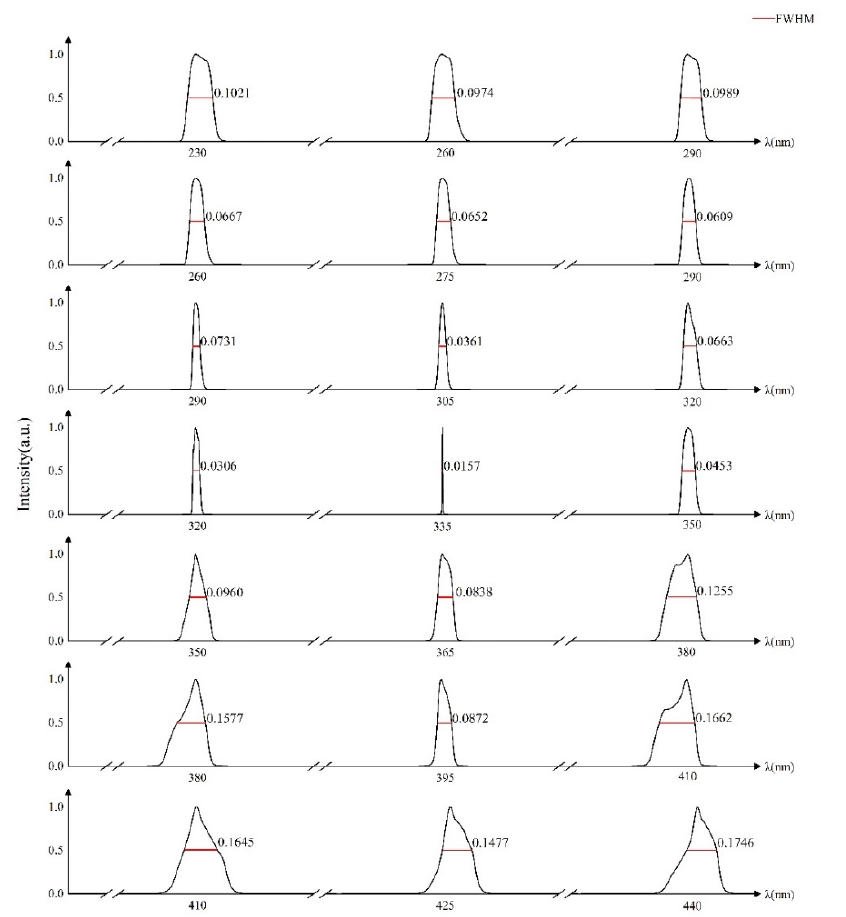
Figure 6. Curve of convolution of f S ( x s ), f LSF , f D ( x d ) at various wavelengths in the seven windows.